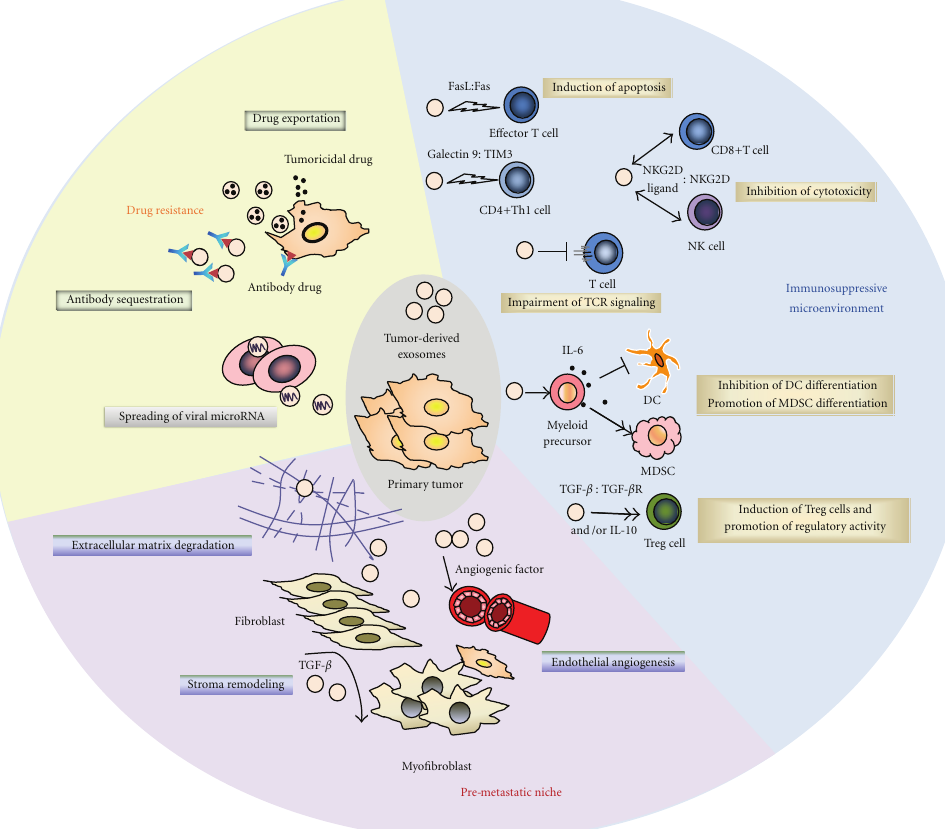
Figure 1: The protumorigenic role of tumor-derived exosomes. Tumor-derived exosomes help create an immunosuppressive tumor microenvironment by inducing apoptosis and impairing the function of e ff ector T cells and NK cells, skewing DC di ff erentiation into MDSCs as well as promoting Treg cell activity. They also contribute to the establishment of a pre-metastatic niche by enhancing angiogenesis, remodeling stromal cells, and promoting extracellular matrix degradation. Tumor-derived exosomes also function as delivery vehicles to transfer microRNA and mRNA to neighboring cells. Moreover, tumor-derived exosomes can help tumor cells develop drug resistance by exporting tumoricidal drugs or neutralizing antibody-based